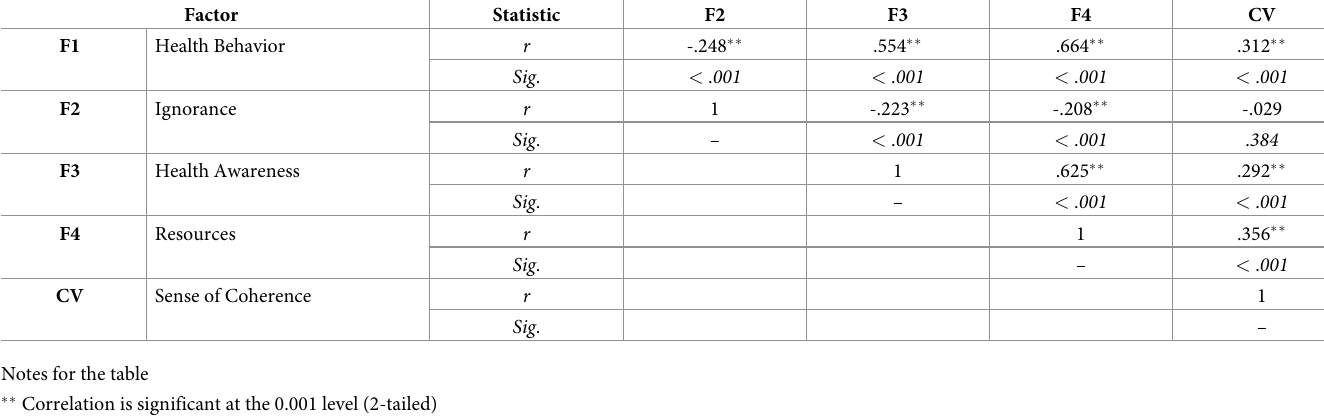
Table 5. Convergent validity (bivariate correlations) between ASAS dimensions and SOC-13 questionnaire score.